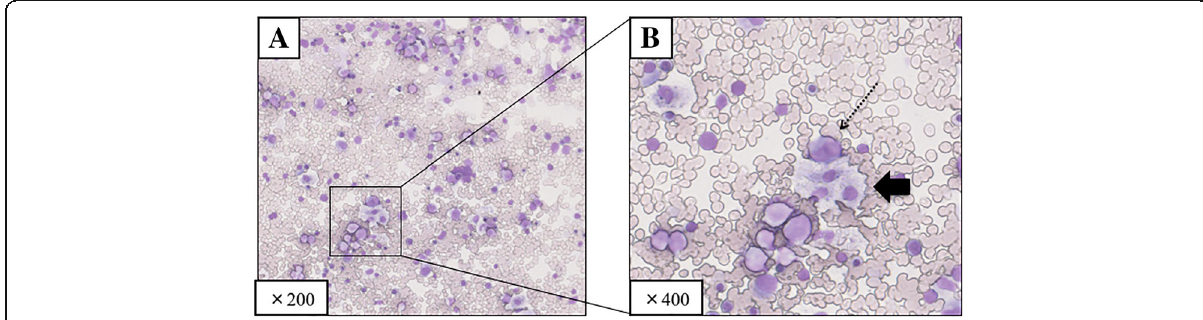
Fig. 2 Bone marrow aspiration revealed many macrophages showing phagocytosis of hematopoietic cells. Dotted arrow shows macrophages phagocytosing neutrophils; thick arrow shows macrophages phagocytosing platelets. a Low-power view, × 200; b high-power view, × 400